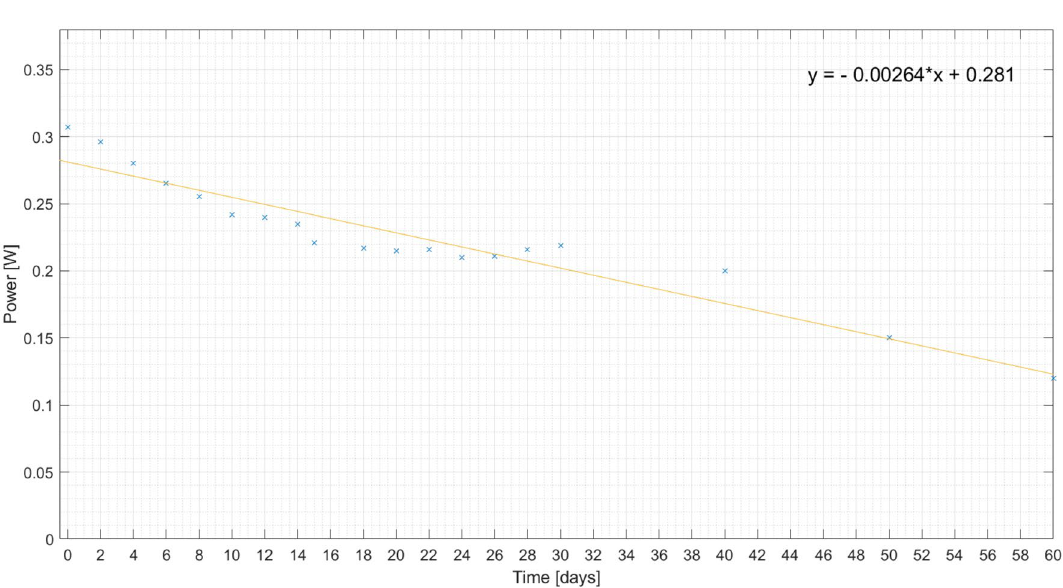
Figure 23. Measured output power on polished aluminium plate (plate 3) for 60 days and respective linear